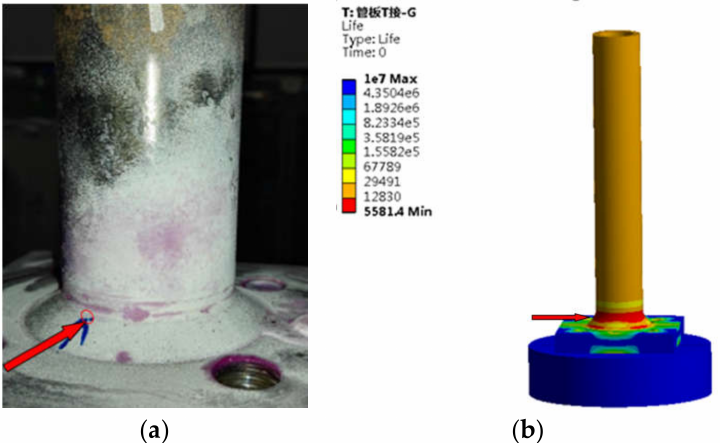
Figure 16. Comparison of fatigue damage in T-type tube-plate joint ( a ) Test result ( b ) Finite element result.